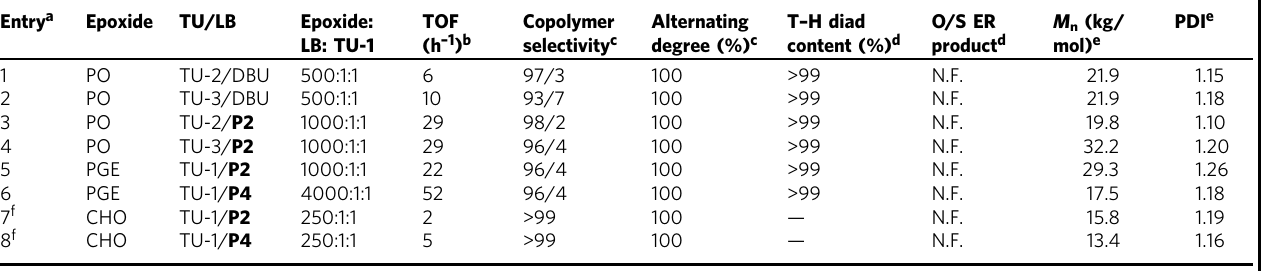
Table 2 The copolymerization of COS with various epoxides by using various TU/LB pairs Entry a